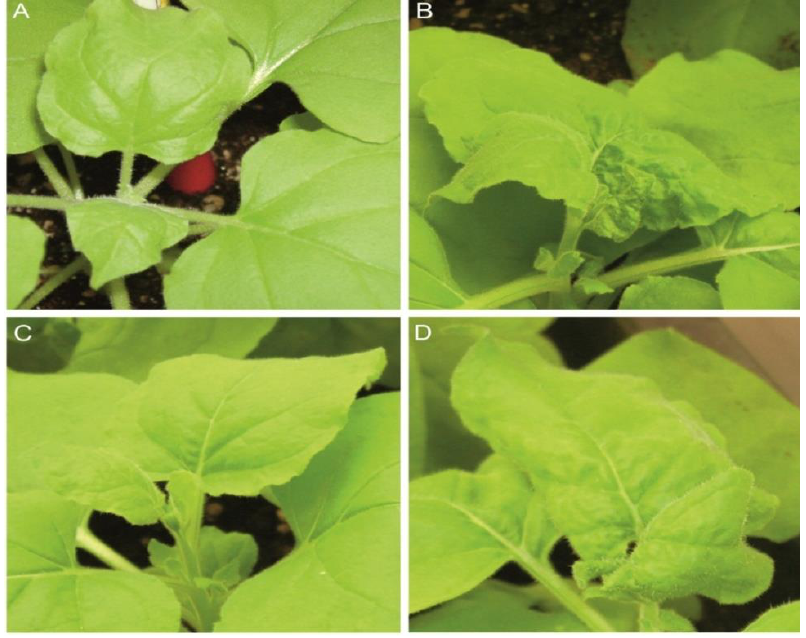
Figure 1. Comparison of the symptoms of PepGMV-inoculated N. benthamiana plants in different bioassay groups. A) Healthy plant used as negative control. B) Plant 10 days after inoculation with PepGMV infectious clone (positive control) showing severe leaf curling and distortion of the systemic, young leaves. C) Plant agro-infiltrated with CIRP construct challenged with PepGMV showing no symptoms. D) PepGMV inoculated, CIRT-protected plant showing light to mild